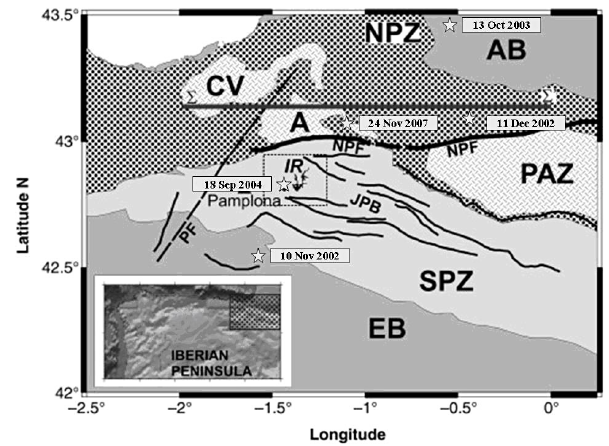
Fig. 1. Location of the main events corresponding to the main clusters. NPZ = North Pyrenean Zone; PAZ = Palaeozoic Axial Zone; SPZ = South Pyrenean Zone; NPF = North Pyrenean Fault; PF = Pamplona Fault; Palaeozoic Basque Massifs: CV = Cinco Villas Massif; A = Aldudes-Quinto Real Massif. AB = Aquitaine Basin; EB = Ebro Basin; JPB = Jaca-Pamplona Basin; IR = Itoiz Reservoir (Modified from Santoyo et al.,